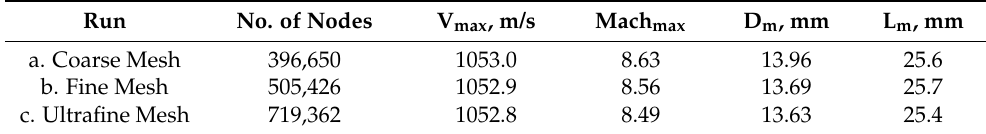
Table 3. The results of mesh independence study for simulation of a free